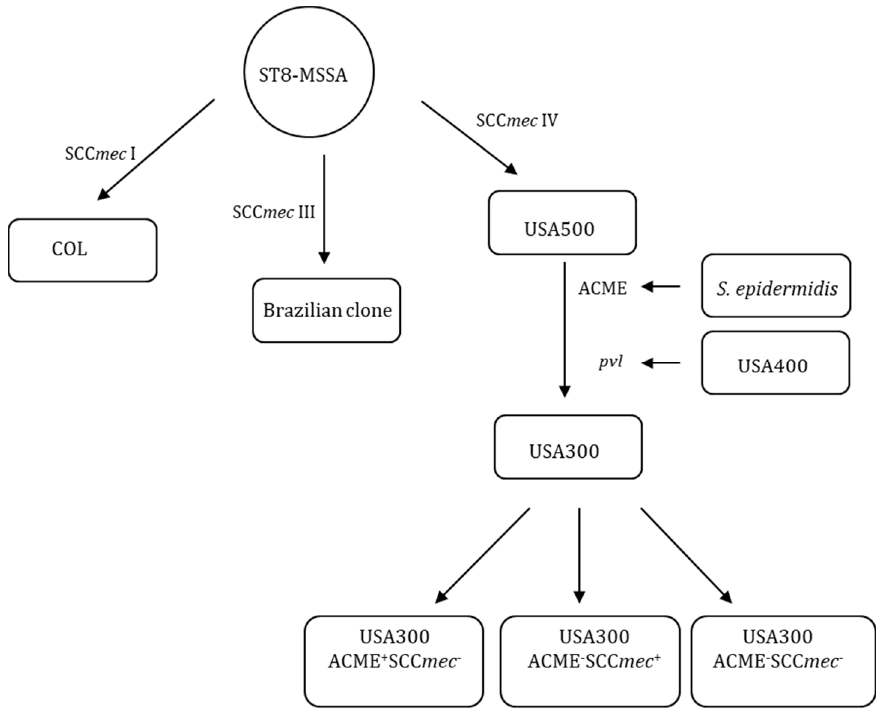
Figure 10. The hypothesized evolution of USA300. ST8-MSSA strains acquired SCC mec IV to generate USA500 strains and USA500 strains acquired the PVL and ACME to generate USA300 strains during evolution. The PVL might have originated from USA400 and ACME might have come from S. epidermidis . USA300 strains can generate USA300 ACME + SCC mec − , ACME − SCC mec + and ACME − SCC mec −